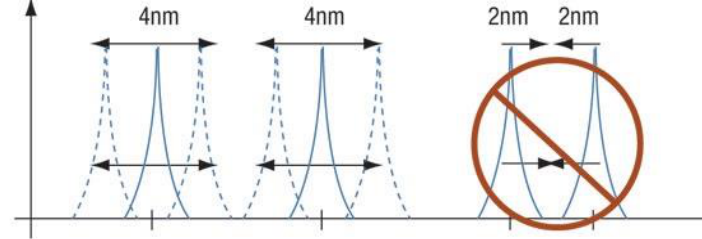
Figure 4. FBG sensors overlapping phenomenon overview.